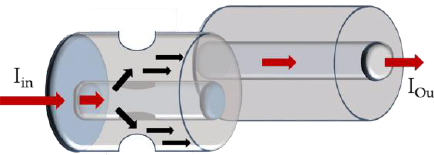
Figure 16. Schematic diagram of an MZI based on a tapered fiber cascaded with a core-offset structure (adapted from [56]).